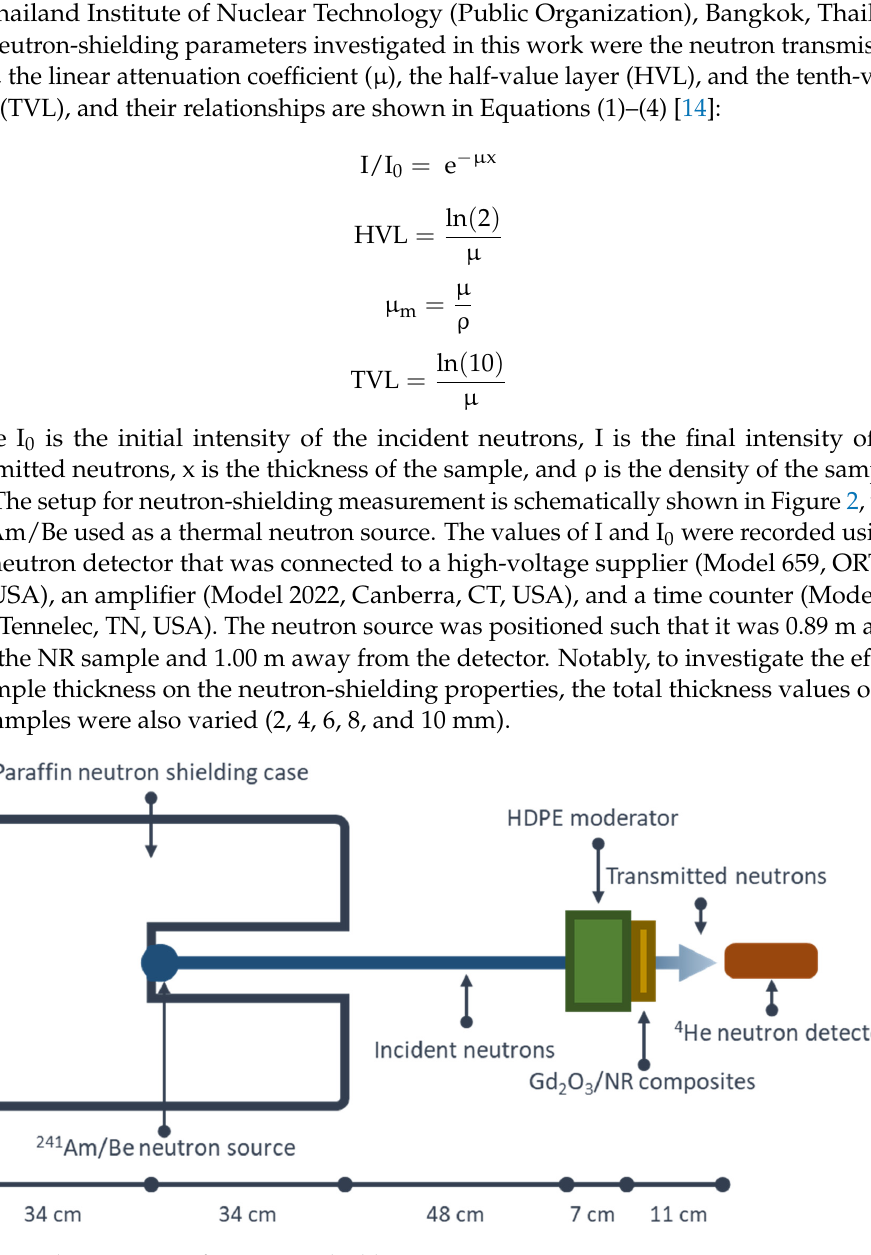
Figure 2. Schematic setup for neutron-shielding measurement.